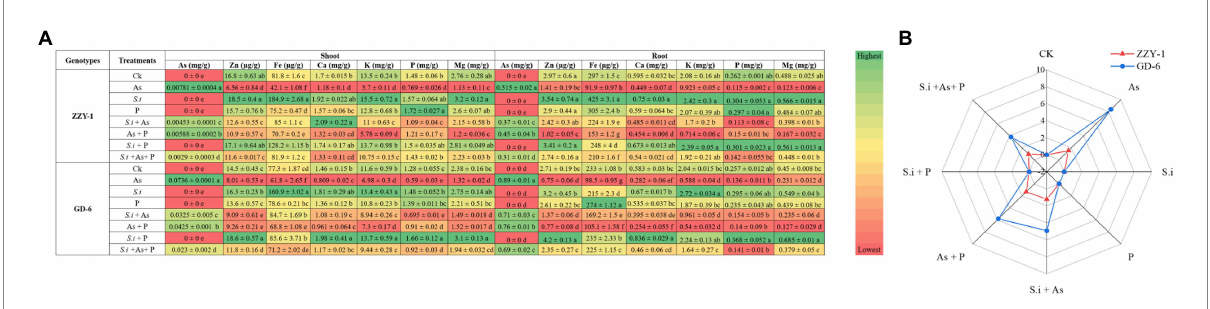
FIGURE 4 Macro-, meso-, and micro-element concentration (A) ; green in color scale displays higher values and red shows lower values. Radar chart representing % As translocation factor (B) . Different letters represent significant difference ( p ≤ 0.05) among the treatments within each